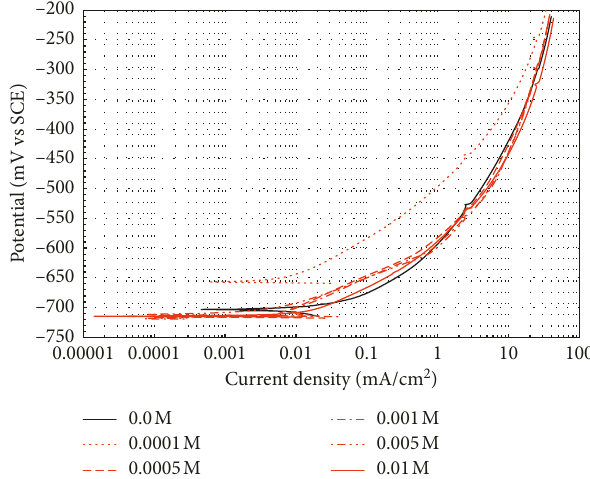
Figure 7: Anodic polarization curves for API X70 steel in 3.5% NaCl solution at different concentrations of inhibitor obtained from permanent